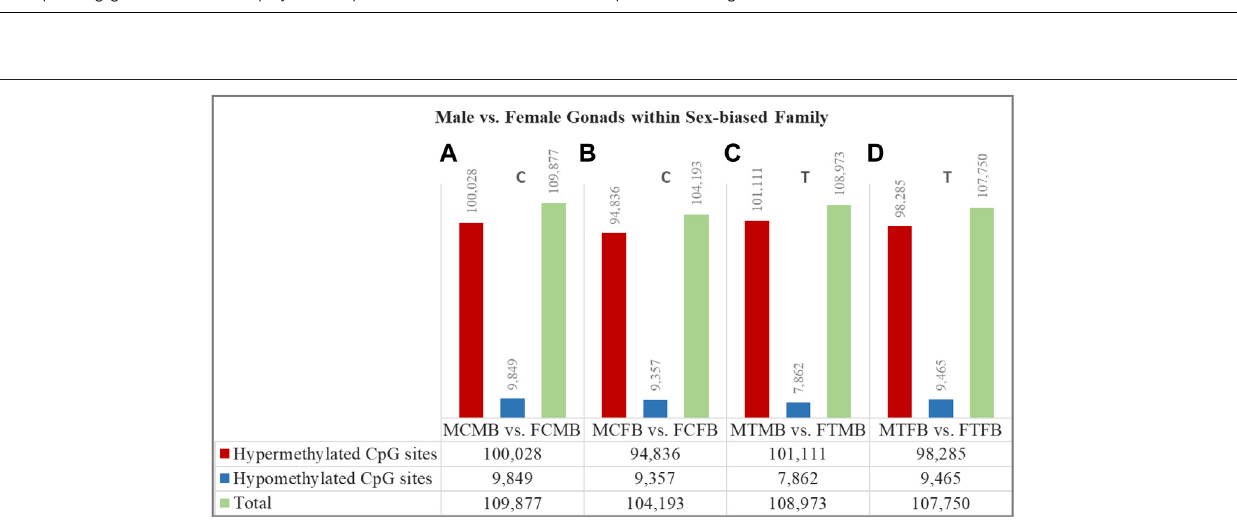
FIGURE6| Differentiallymethylated CpGsites(DMCs)intestesversusovarieswithinmale-biasedandfemale-biasedzebra fi sh families.BarchartsillustrateDMCs in testes vs. ovaries in control group of male-biased (A) and female-biased (B) families (MCMB vs. FCMB and MCFB vs. FCFB, respectively), and in testes vs. ovaries in treatment group of male-biased (C) and female-biased (D) families (MTMB vs. FTMB and MTFB vs. FTFB, respectively).